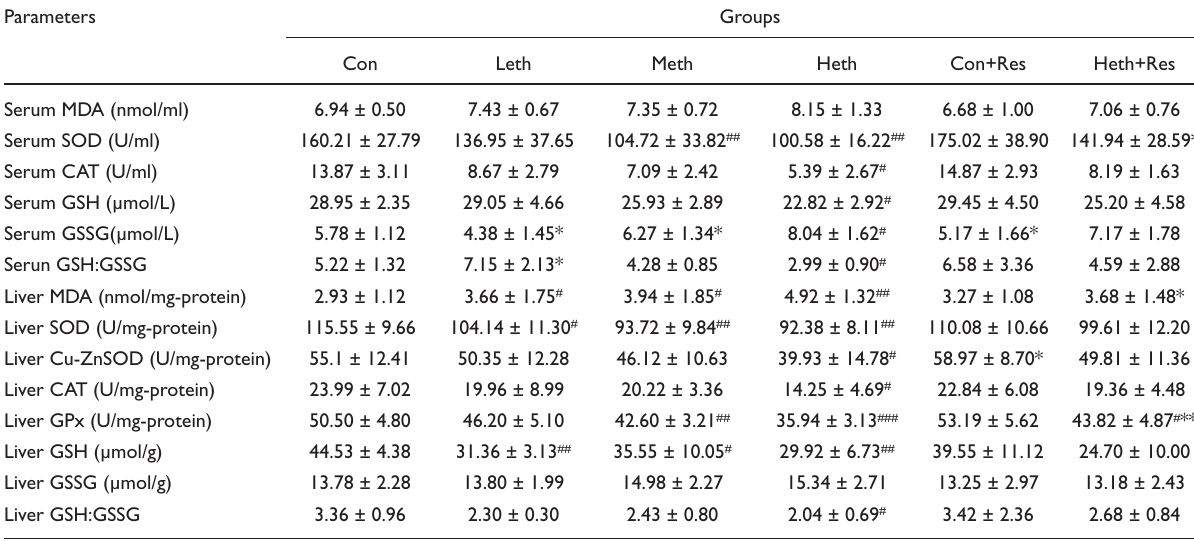
Table 3. Antioxidant parameters and lipid peroxidation products (MDA) in serum and liver of rats after chronically ethanol intake with or without Resveratrol supplemented